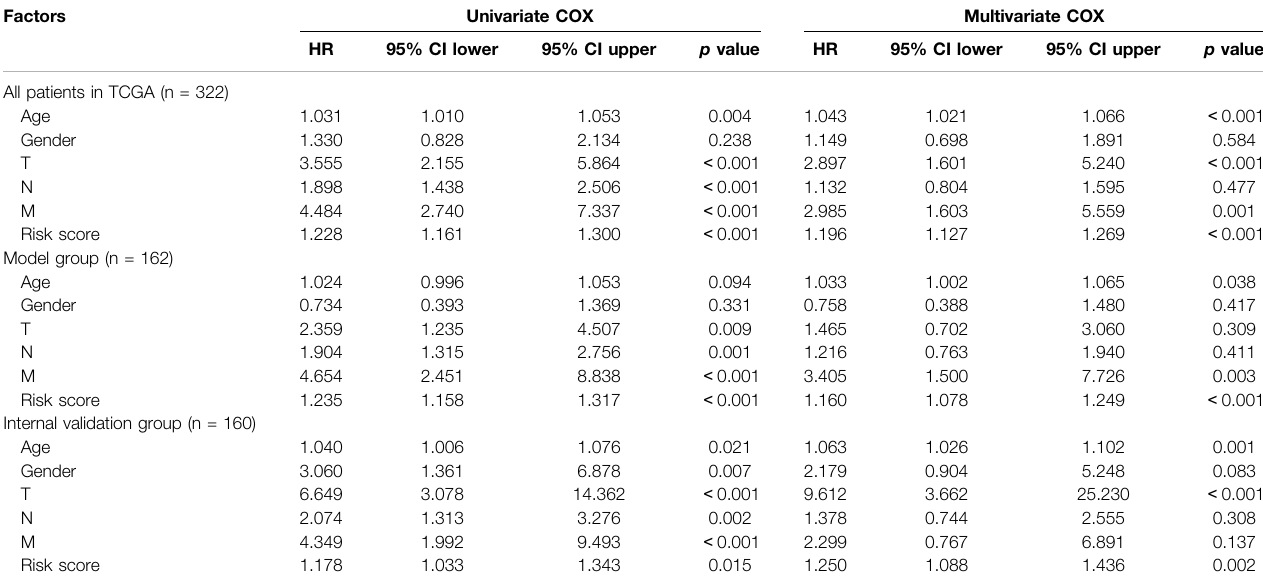
TABLE 2 | Univariate and multivariate COX of prognostic factors in different groups. Factors